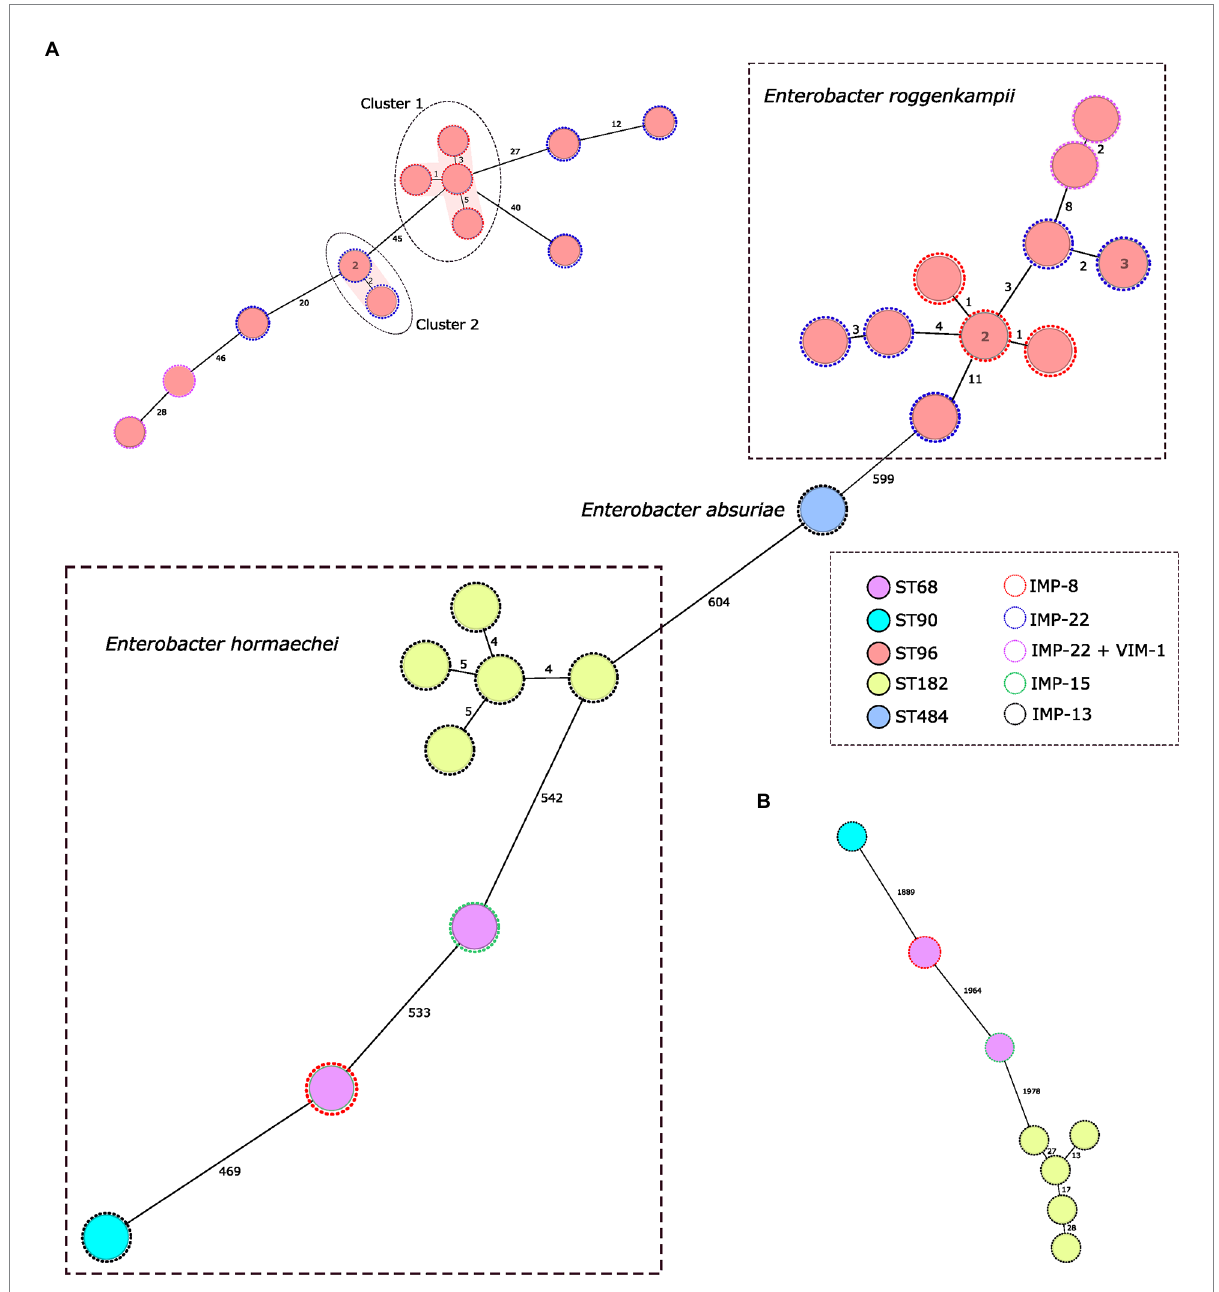
FIGURE 2 Population structure of IMP-producing Enterobacter cloacae complex: minimum-spanning tree. Distances shown are based on cgMLST of 631 genes using the parameter ‘pairwise ignoring missing values’. Fill colors in each circle indicate the MLST type and the color of the dashed line in circles indicates IMP type. (A,B) represent a minimum-spanning tree for each Enterobacter specie based on specific cgMLST of 2.123 and 2.466 genes, respectively, for Enterobacter hormaechei and Enterobacter roggenkampii . Grey ovals represent clusters, applying a threshold of both 5 SNPs and 5